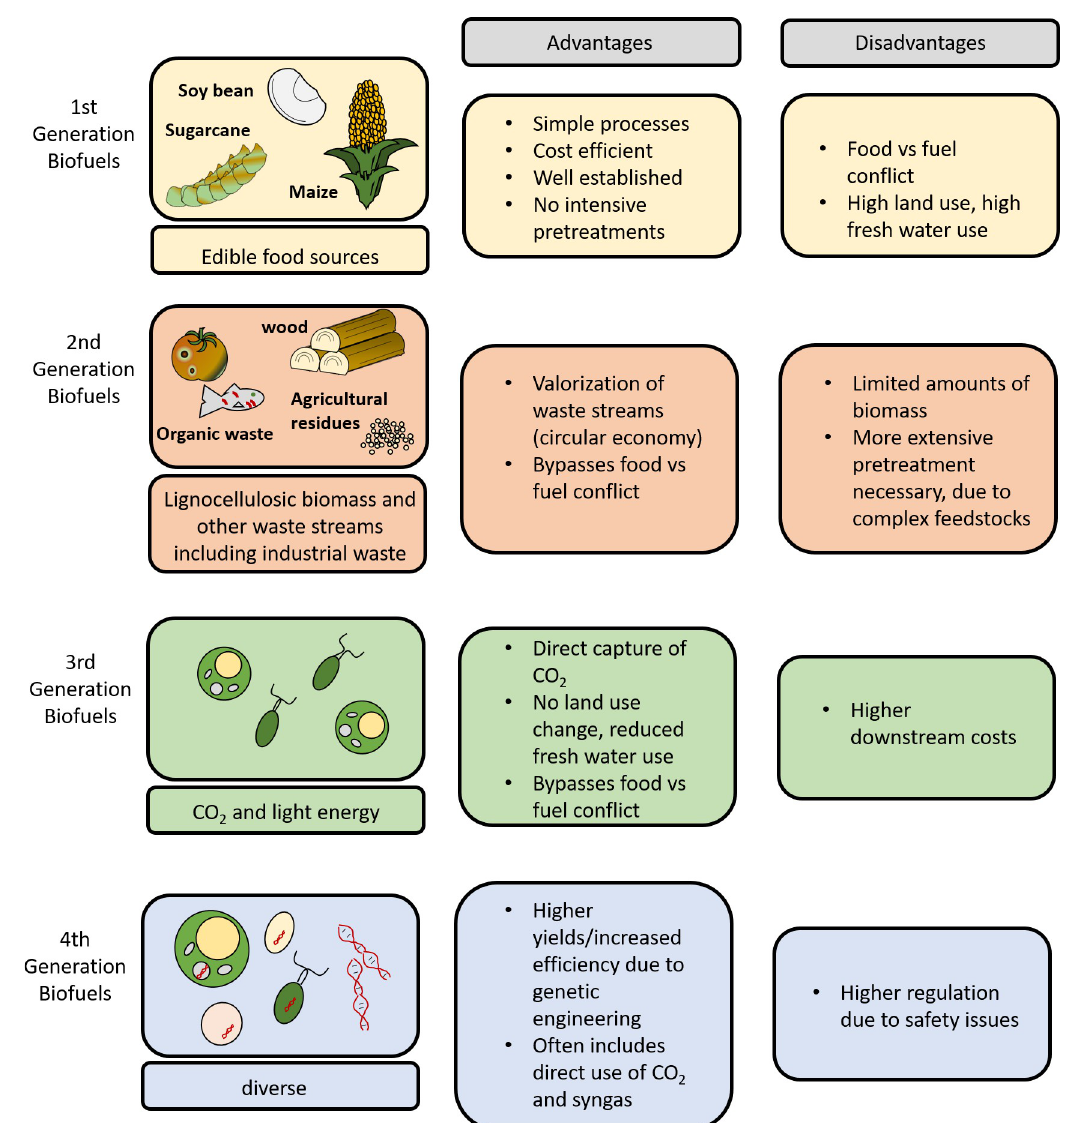
Fig 1. Schematic depiction of the different biofuel generations.Illustrations of possible feedstocks are depicted alongside the advantage and disadvantages associated with each generation of